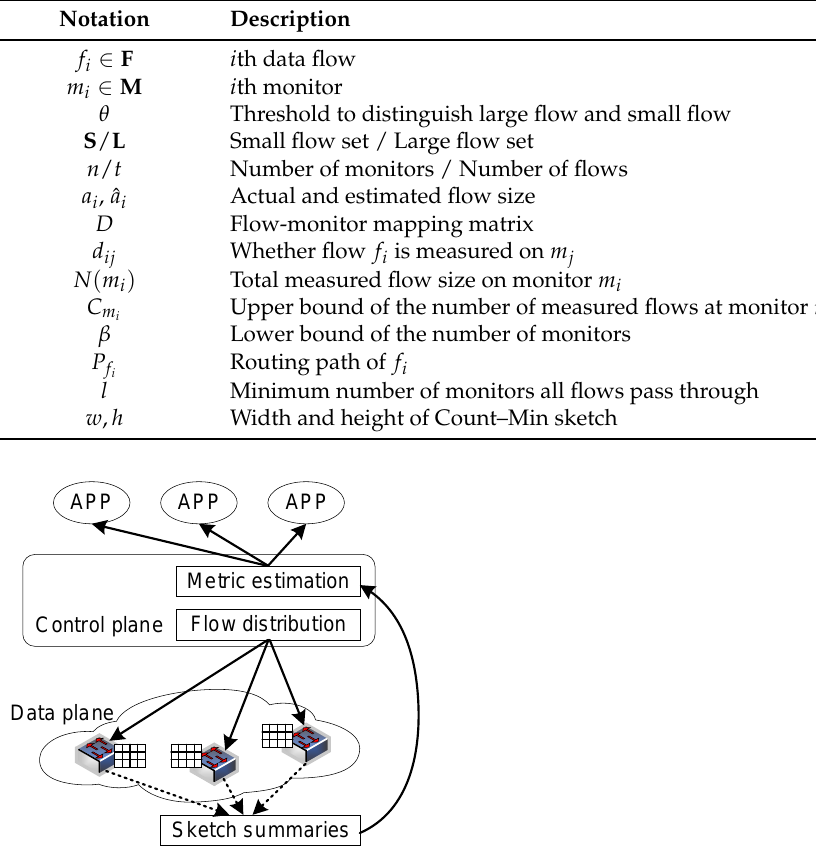
Figure 2. Framework of software-defined network-wide